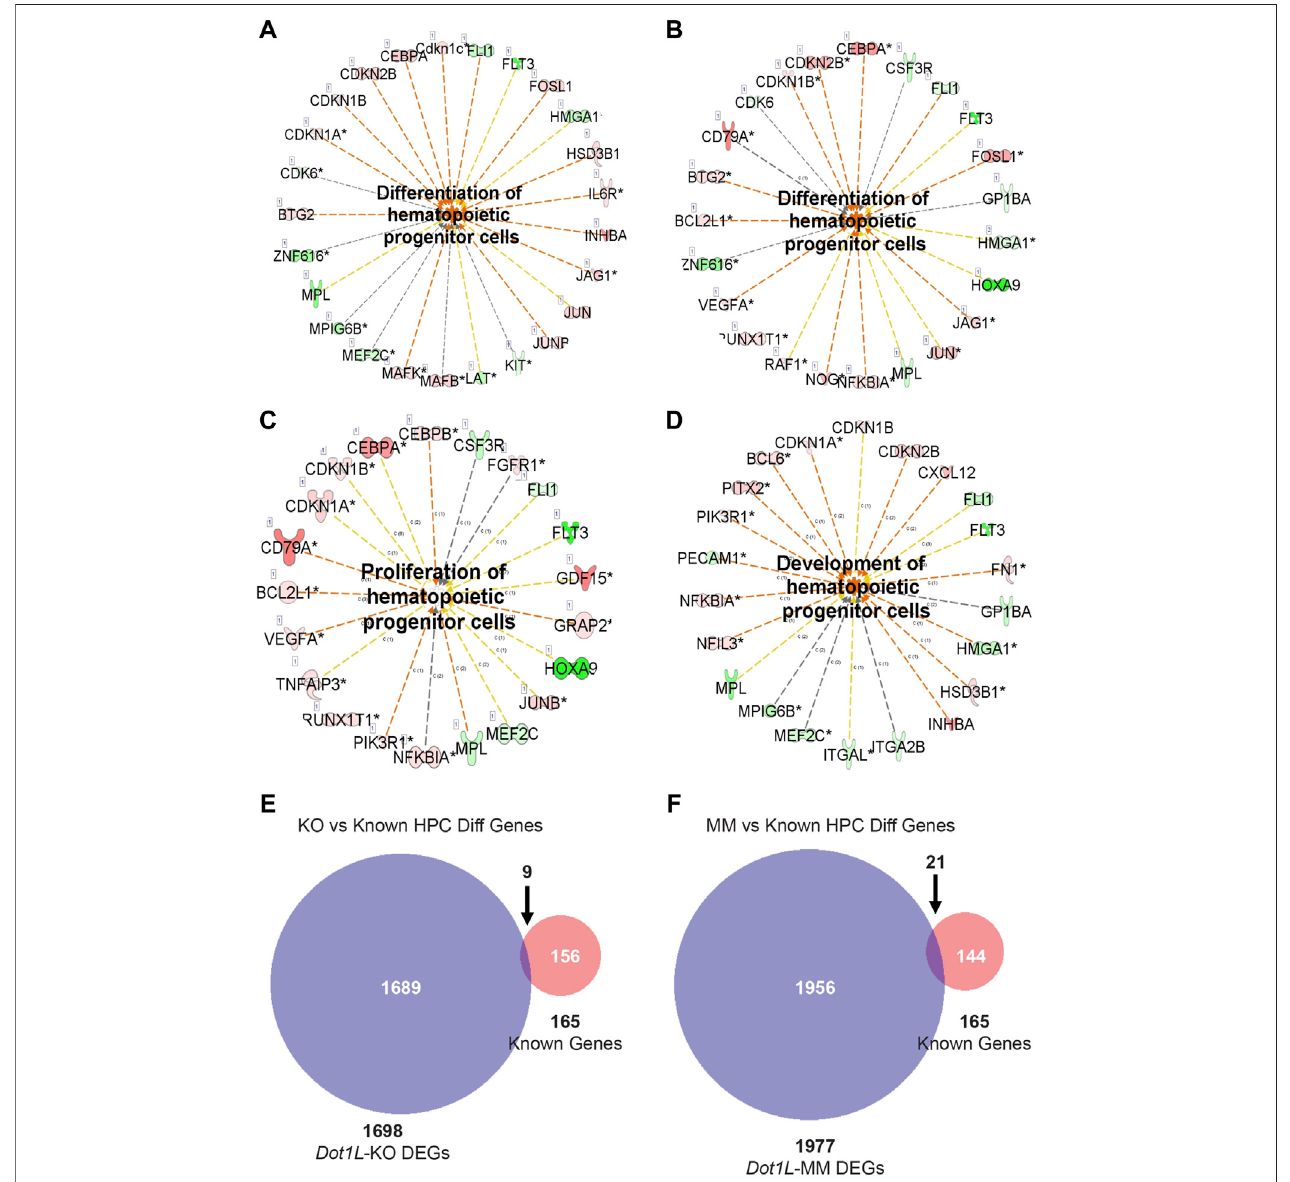
FIGURE 5 | DEGs involved in proliferation and differentiation of HPCs. DEGs from RNA-seq data representing wildtype (WT) versus Dot1L -KO (A,C) , and WT versus Dot1L -MM (B,D) were subjected to IPA analysis and detected many genes crucial for proliferation and differentiation of HPCs. In addition, we curated a group of genes( n =165)fromtheMGIdatabase(www.informatics.jax.or)thatareinvolvedindifferentiationofHPCsandcomparedthosewiththeDEGsidenti fi edinourRNA-seq data. Most of the DEGs in Dot1L -KO or Dot1L -MM ESRE cells were found to be novel (E,F) . ‘ c ’ next to the relationship lines (A-D) stands for relationship types of ‘ Causation/Leadsto ’ andthenumbersnextto ‘ c ’ standforthenumberofreference fi ndingssupportingthatlinkofrelationship.Thenumberbeforethegenename (A-D) inside the box representsnumber of splice variants. Asterisk (*) marksnext to a gene name (A-D) indicate that multiple identi fi ers in the dataset fi le map toa single gene.